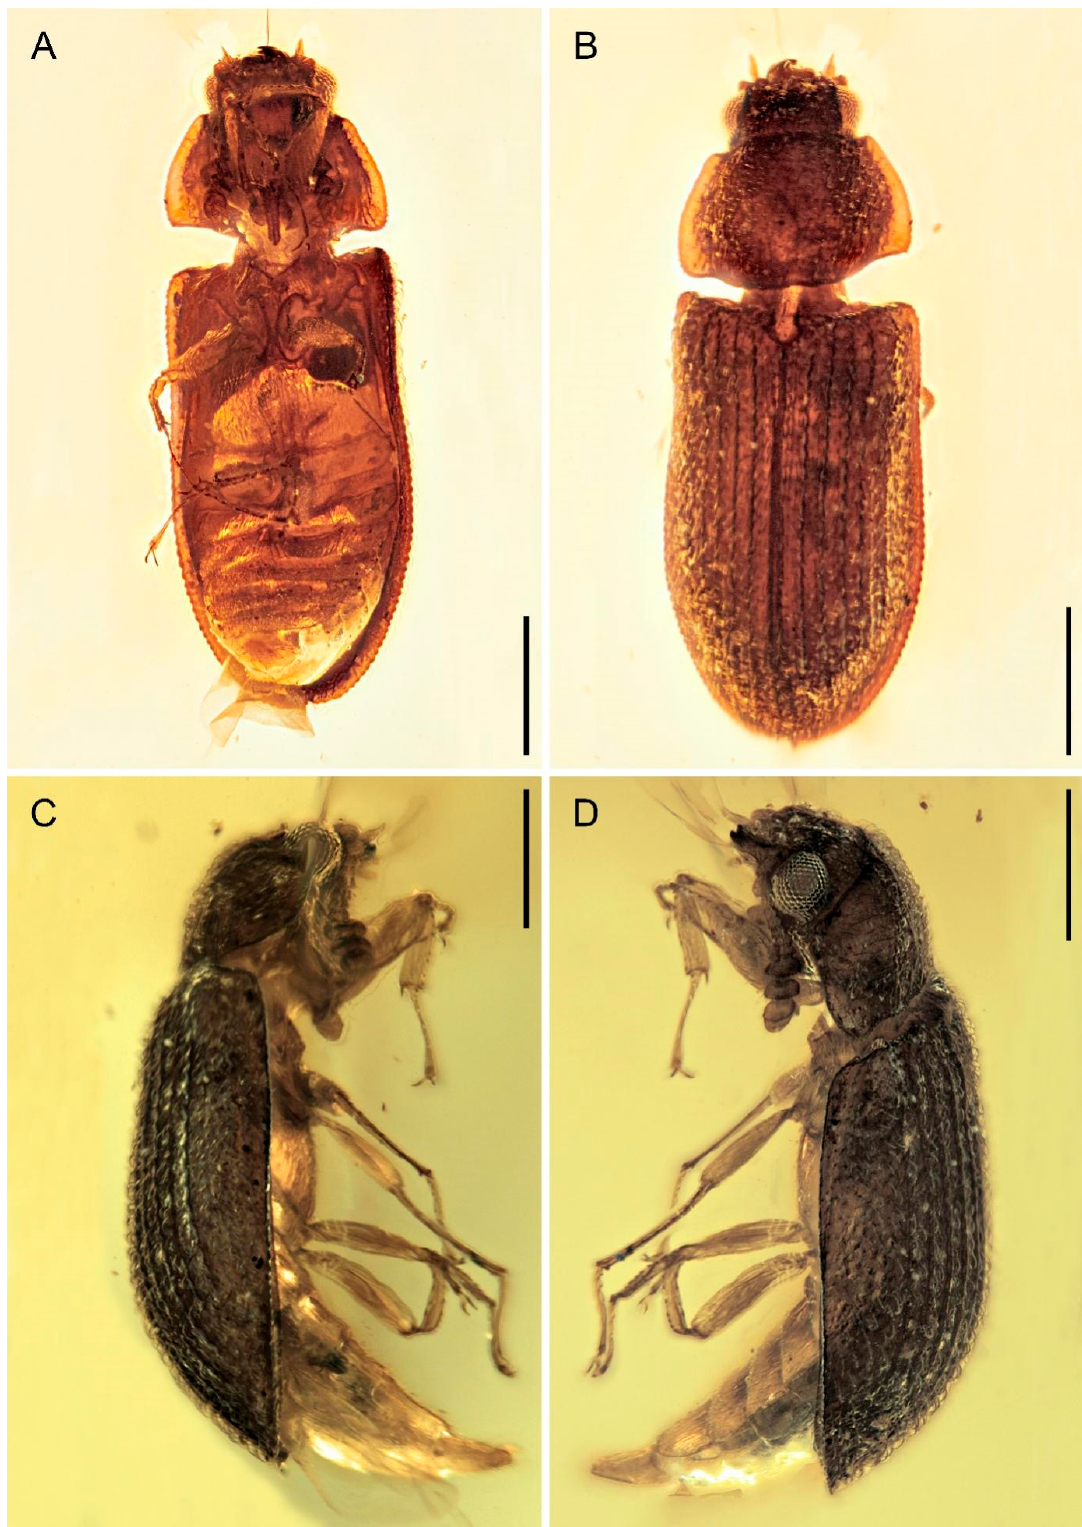
Figure 2. Photograph of Gracilenticrus burmiticus gen. et sp. nov. in Upper Cretaceous amber from Myanmar, holotype (CNU-COL-MA2021001), under incident light. ( A ) Ventral view. ( B ) Dorsal view. ( C , D ) Lateral view. Scale bars = 0.5 mm.